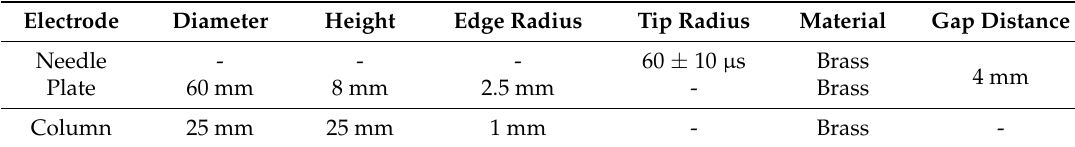
Table 1. Parameters for the electrodes.